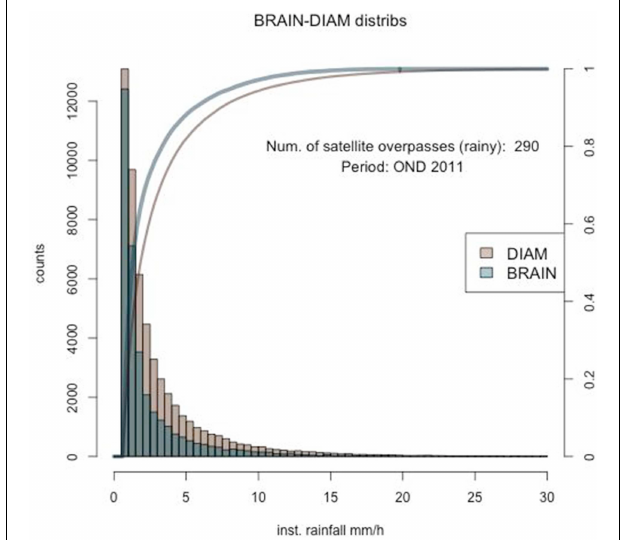
FIGURE 6 | Histogram and cumulative distribution function of the rain rate distribution over the Meteo-France radar site of ’La Martinique’ Island for the OND 2011 period as detected by the BRAIN retrieval (blue) and the radar